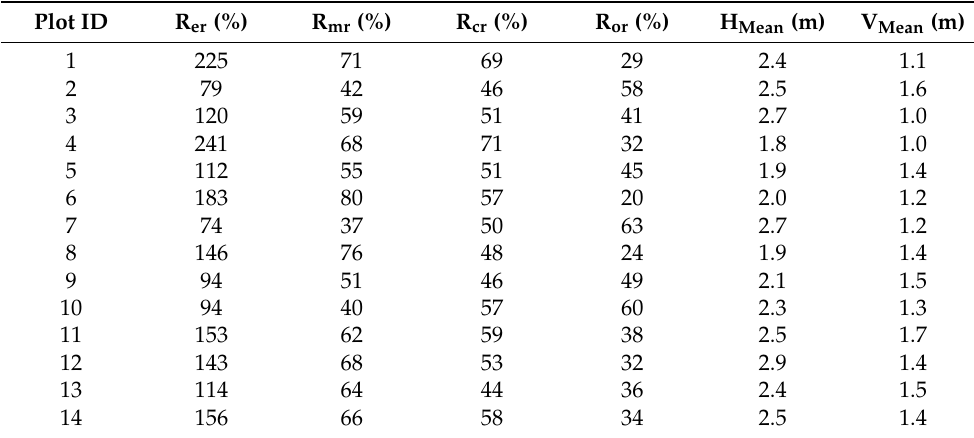
Table 2. Detection performance for each plot.